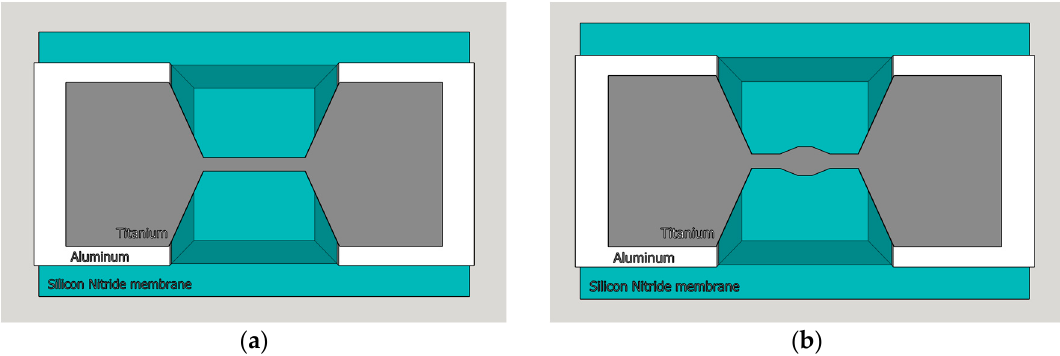
Figure 6. New titanium micro-bridge design with bridge expansion and cavity ( a ) current Ti micro-bolometer design ( b ) proposed new design.